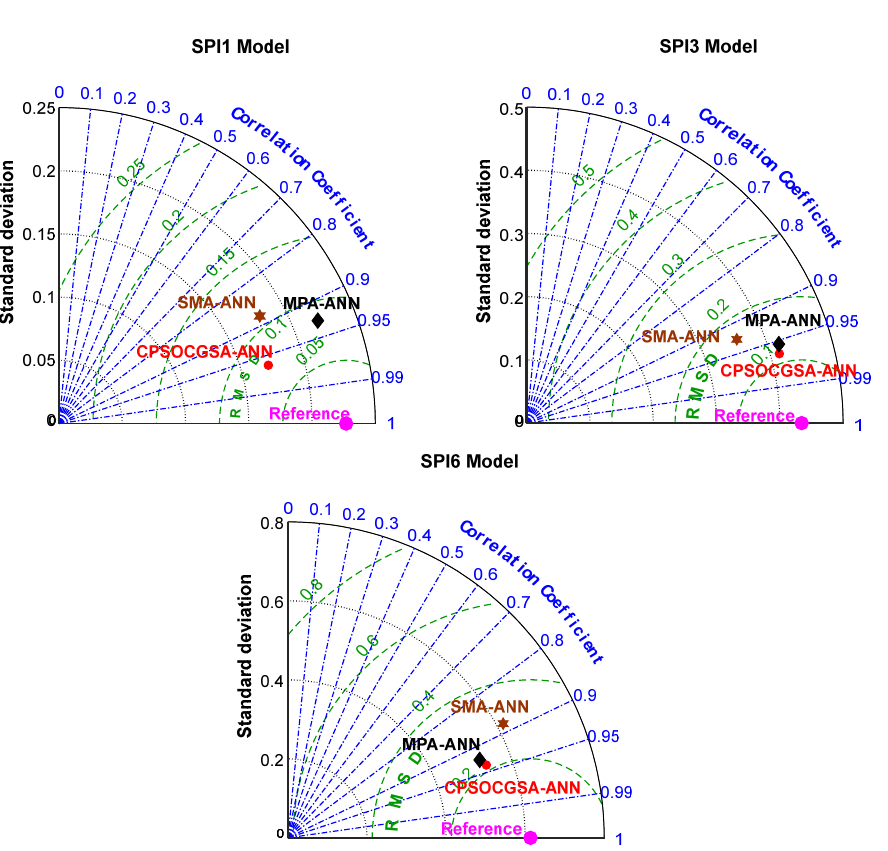
Figure 9. Taylor diagram for CPSACGSA-ANN, MPA-ANN, and SMA-ANN prediction models. A graphical test was employed to confirm the capability of the hybrid models to gener- alise SPI time series (i.e., SPI 1, SPI 3, and SPI 6) in the validation stage. Figure 10 shows the measured SPI data and predicted SPI data from CPSOCGSA-ANN, MPA-ANN, and SMA- ANN. It can be noticed that the forecasted data from CPSOCGSA-ANN follows the trend and periodicity of the measured data, and it is the closest to the measured data from MPA-ANN and SMA-ANN according to the scale of error. Several slight deviations in the predicted time series may have resulted from the effect of climatic factors’ fluctuations.